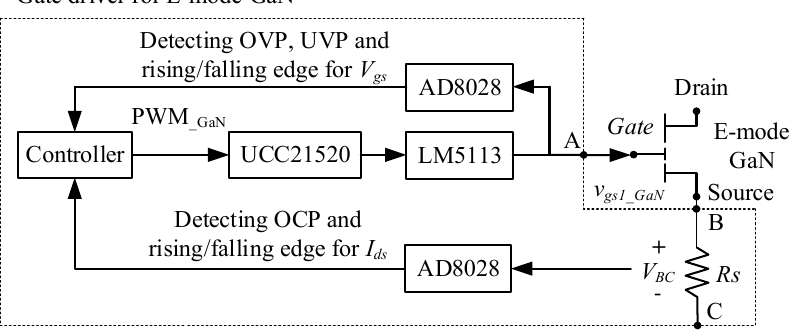
Figure 8. Block diagram of the gate driver circuit.